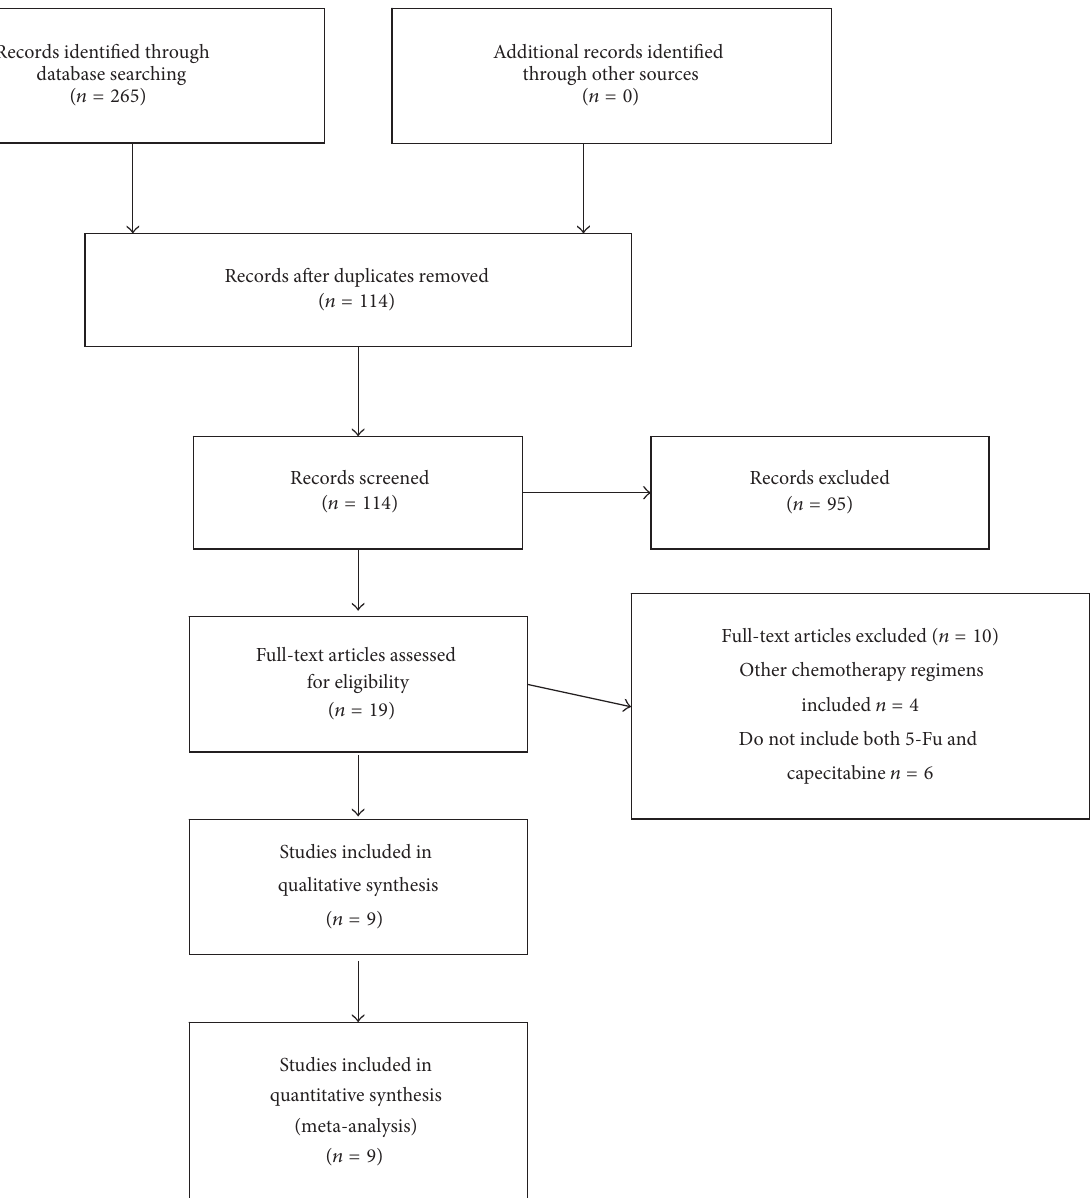
Figure 1: The Quality of Reporting of Meta-Analyses (QUOROM) statement flow